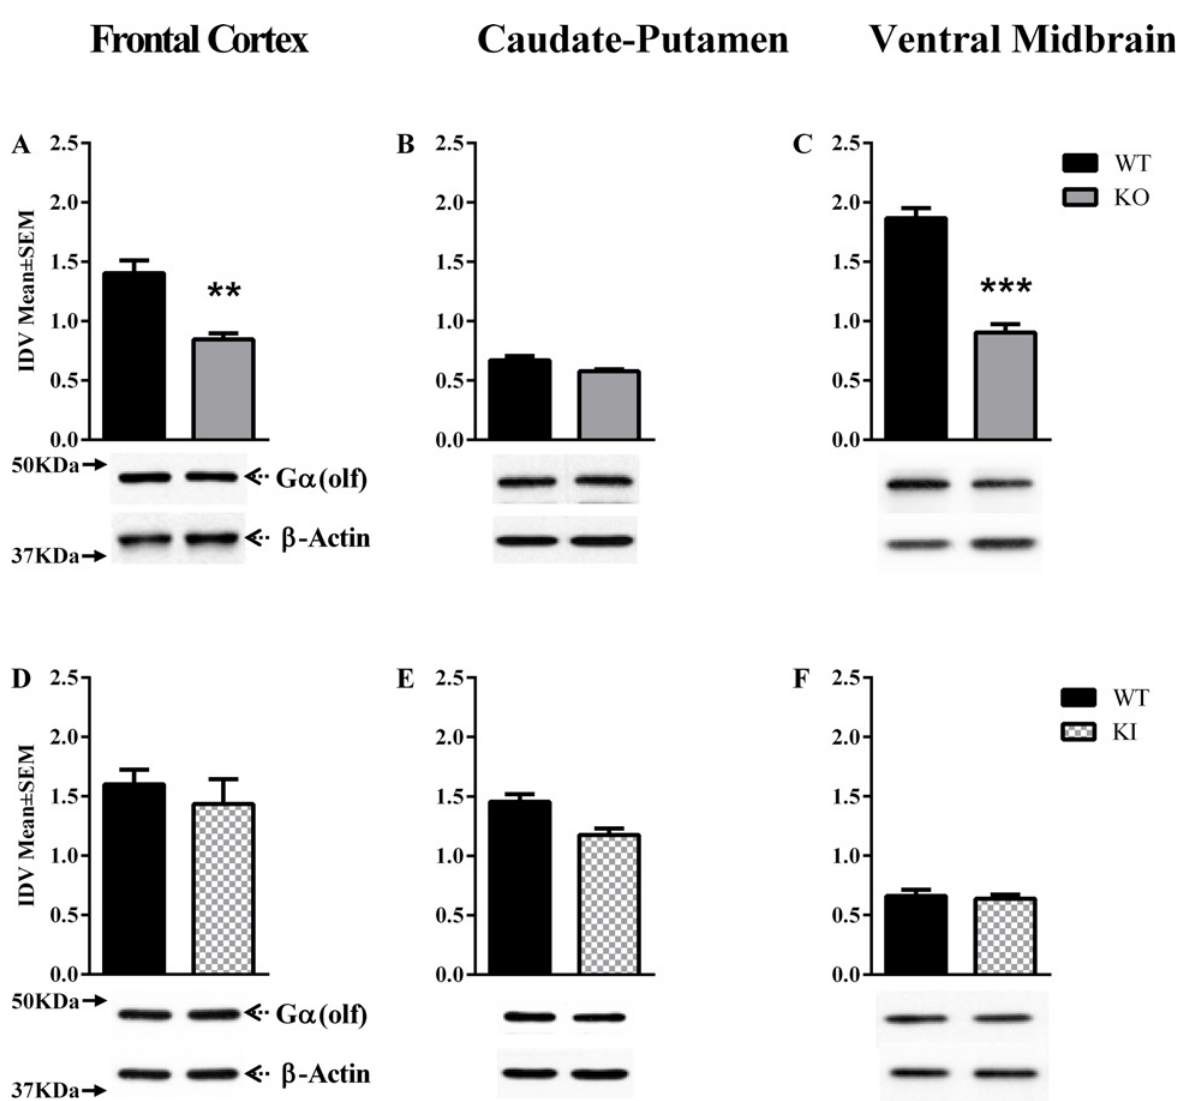
Fig 3. G α (olf) and G α (s) expression at P60. G α (olf) and G α (s) expression in the frontal cortex, caudate-putamen and ventral midbrain of Dyt1 KO, and, Dyt1 KI mice at postnatal day 60 (P60; A-F). In each panel, the upper band shows G α (olf) (A-F), and the lower band shows β -actin, which was used as a loading control. The bar graphs in each panel represent G α (olf) band intensity (mean ± SEM) normalized to intensity of loading control (integrated density value; IDV). The names of the mouse lines ( Dyt1 KO, Dyt1 KI) are indicated to the right ( ** p < 0.01, *** p < 0.001; n = 3 or 4).